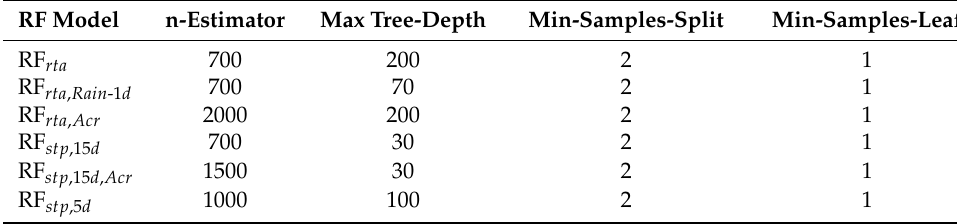
Table 3. Tuned hyper-parameters for constructed RF models.